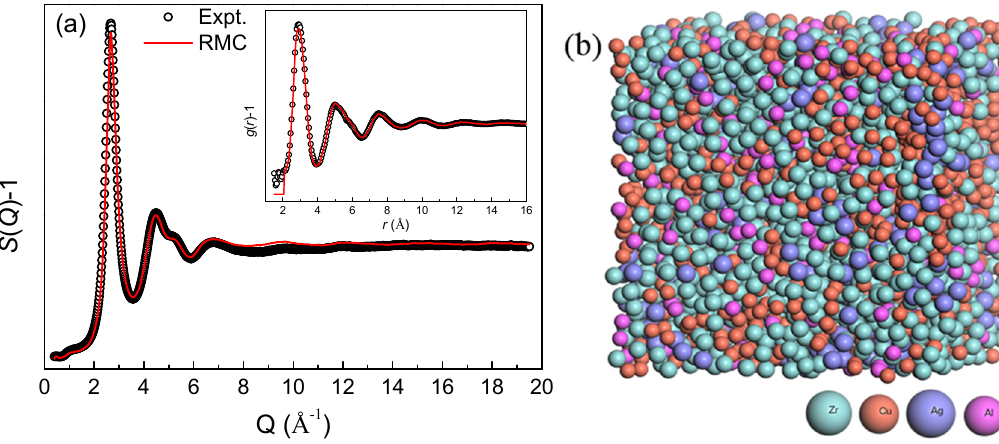
Figure 1. Reverse Monte Carlo modeling to reproduce the experimental synchrotron diffraction data. ( a ) The experimental structure factor (open circles), S(Q) , and fitting spectra (solid lines). PDF data is given as the inset pattern; ( b ) A review of the final RMC configuration.